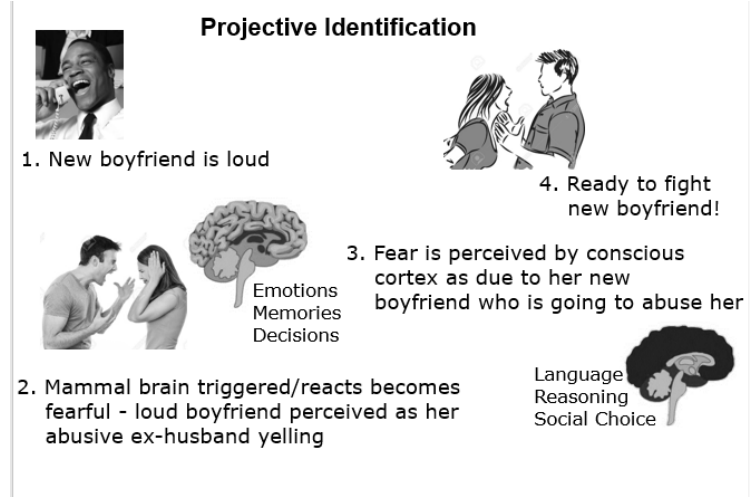
Figure 5. Illustration of the defense mechanism projective identification using dual-processor model.